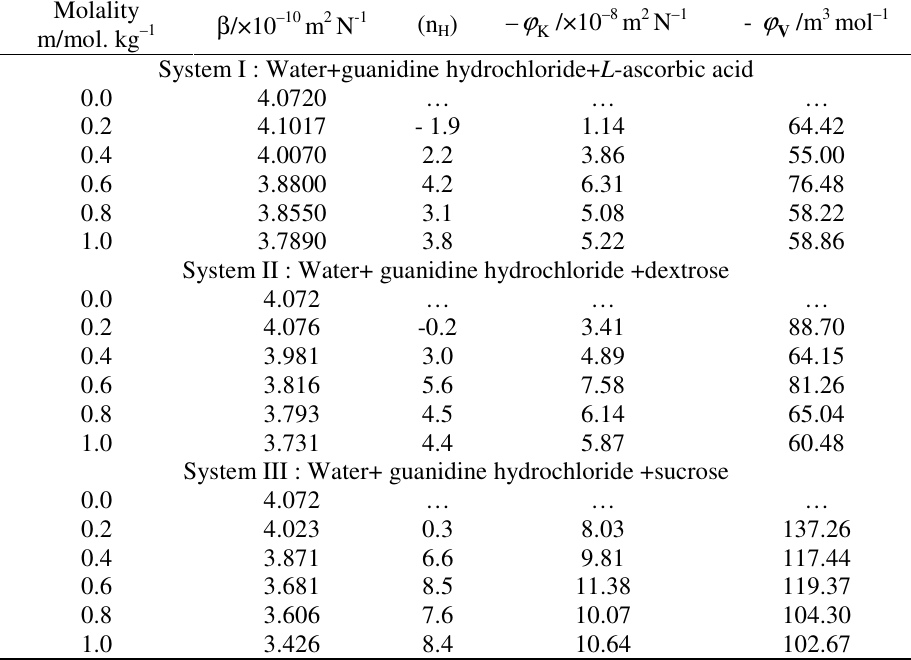
), apparent molal H ϕ ) of L -ascorbic acid, dextrose and V